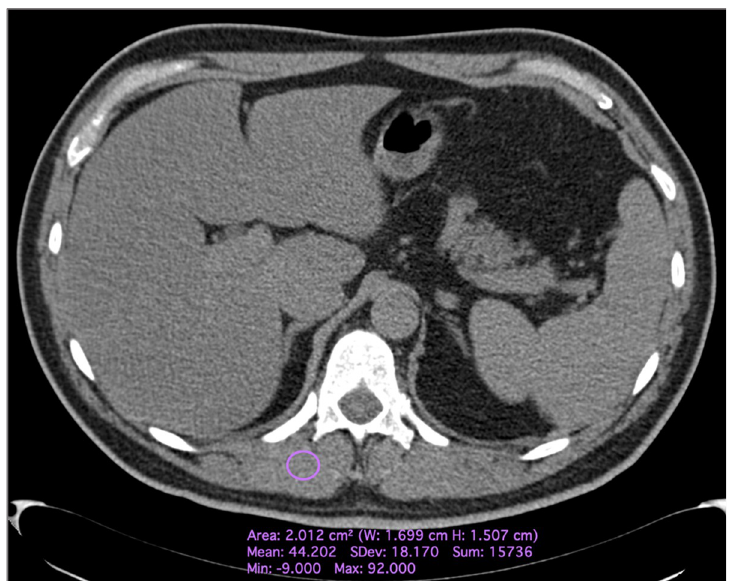
Fig 1. Axial Computed Tomography images of a 59 years-old male affected by COVID-19, hospitalized in a COVID-19 ward, demonstrating the applied method of measurements of muscle densitometry. A circular 2 cm size region of interest was placed on the right paravertebral muscle at the level of the 12 th dorsal vertebra and the mean Hounsfield unit value collected.